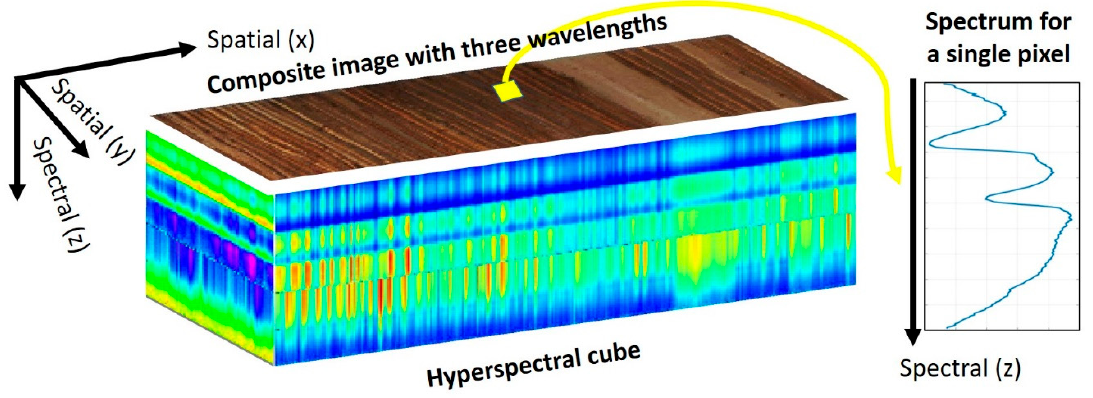
Figure 4. Hyperspectral cube composed of two spatial dimensions (x along and y across the sample, which can also be viewed as time and cross-time dimensions) and one spectral dimension (z as wavelengths, wavenumbers, or energies). Each pixel contains a spectrum, and wavelength assemblage can create a composite image.